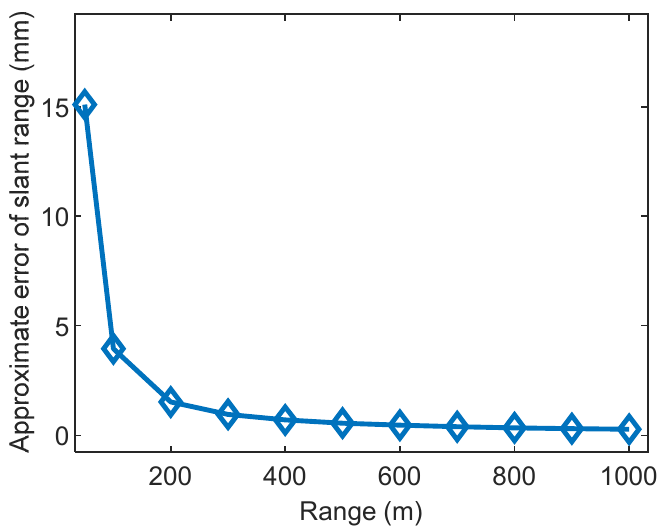
Figure 12. Approximate range errors of different radial distances .